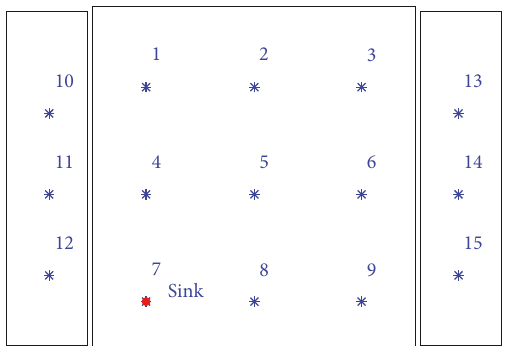
Figure 7: Residual energy of node.